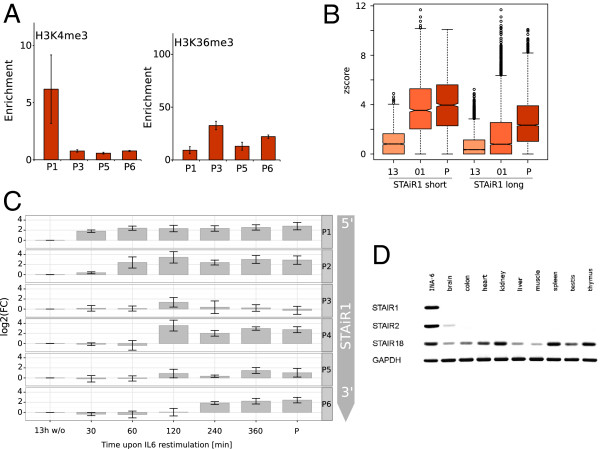
STAiR1 – a continuous specifically expressed transcript.(A) INA6 cells were restimulated with IL-6 as described in Figure 3A and chromatin immunoprecipitated (ChIP-ed) for tri-methylated H3K4 and H3K36, respectively. Enrichment compared to an IgG isotype control was assessed by quantitative real-time PCR using primer sets P1, P3, P5 and P6. The location of respective amplicons is shown in Figure 3A. Strong enrichment for H3K4me3 is observed only within P1, indicating an active promoter region. H3K36me3 shows strong enrichment throughout the STAiR1 transcript. (B) Expression z-score aggregated over STAiR1 expressed after 1 h (STAiR1 short, chr18:41,591,020-41,720,348) or the entire annotated STAiR1 transcript (STAiR1 long). (C) INA6 cells were restimulated with IL-6 as described and induction of STAiR1 was detected using qRT-PCR with primer sets P1 to P6, as shown in Figure 3A, and using GAPDH for normalization. This expression time course is consistent with the time-dependent elongation of STAiR1 observed in the tiling array data shown in Figure 3A. (D) Expression of macroRNAs in different tissues, as detected by reverse transcriptase PCR, using GAPDH as a normalization control. Tissue specificity varies strongly between different macroRNAs. STAiR, STAT3-induced RNA; STAT3, signal transducer and activator of transcription-3.